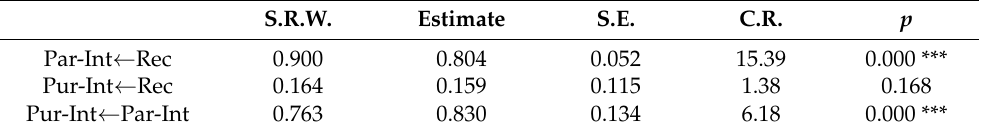
Table 6. Regression weights.